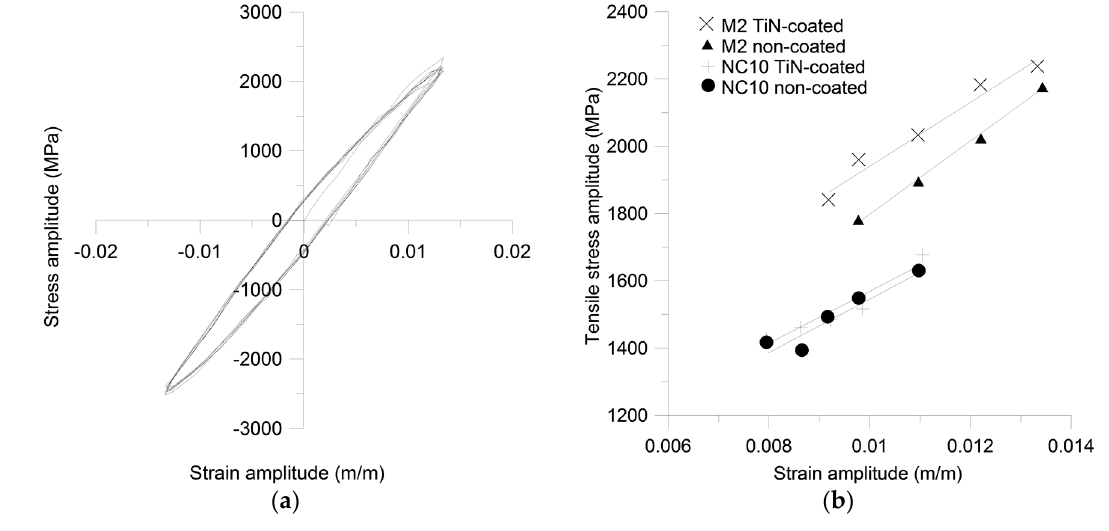
Figure 20. Material fatigue response ( a ) Hysteresis loop for non-coated M2 tool steel at a strain amplitude of 0.0135, after ref. [53]; ( b ) Material fatigue response, cyclic strain amplitude—strain curves after ref. [53].